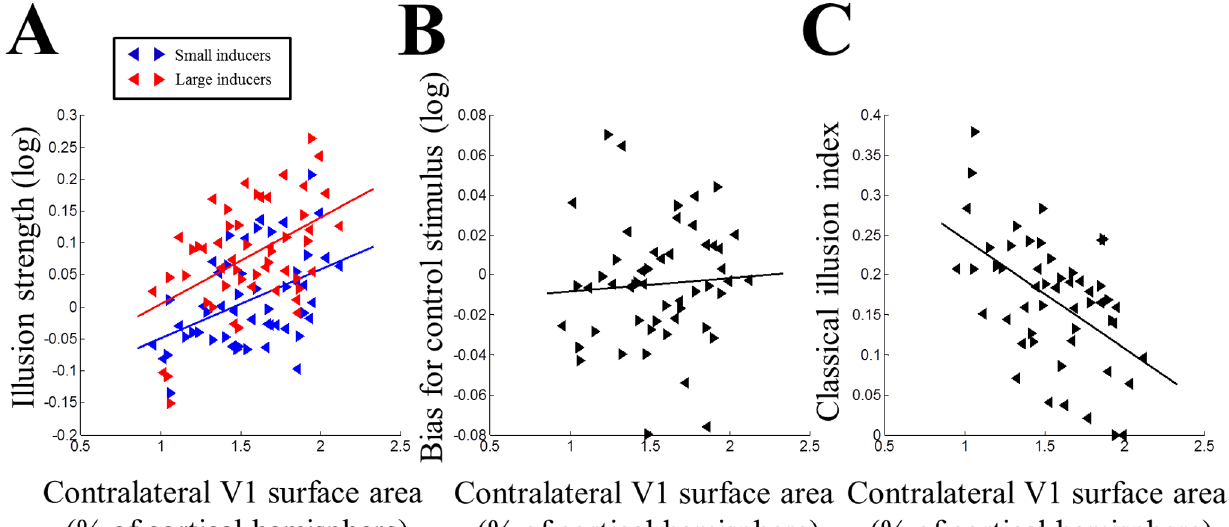
Figure 3. Illusion strength and V1 surface area. A. Individual illusion strengths plotted against the surface area of contralateral V1 (expressed as percentage of the cortical hemisphere). Blue: small inducers. Red: large inducers. B. Bias in size perception for the control stimulus (without any inducers) plotted against contralateral V1 surface area. C. ‘‘Classical illusion index’’ calculated from the illusion strengths for small and large inducers plotted against contralateral V1 surface area. In all plots, left and right pointing triangles denote measurements from left and right visual hemifields in individual participants, respectively. Solid lines are linear regression fits.